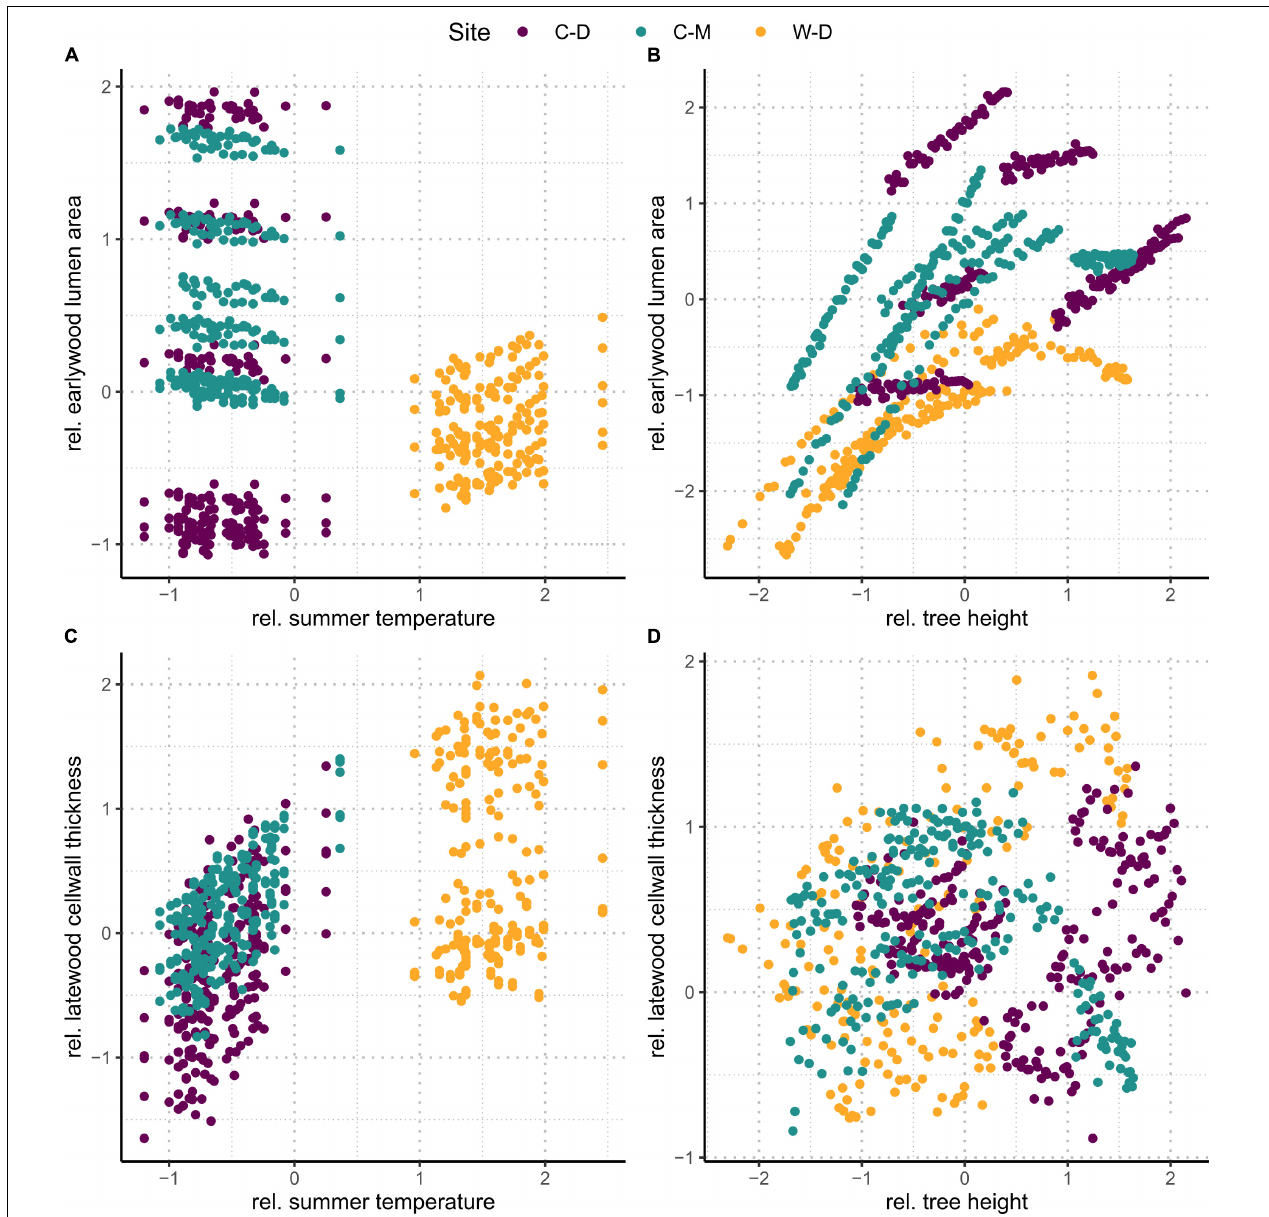
FIGURE 4 | Upper row (A,B) : predicted relative earlywood lumen area. Lower row (C,D) : predicted relative latewood cell wall thickness. Left column (A,C) : values predicted on a dataset where height was set to the mean (i.e., 0). The figures show the effect of summer temperature without the effect of height. Right column (B,D) : values predicted on a dataset where summer temperature was set to the mean (i.e., 0). The figures show the effect of height without the effect of summer temperature.